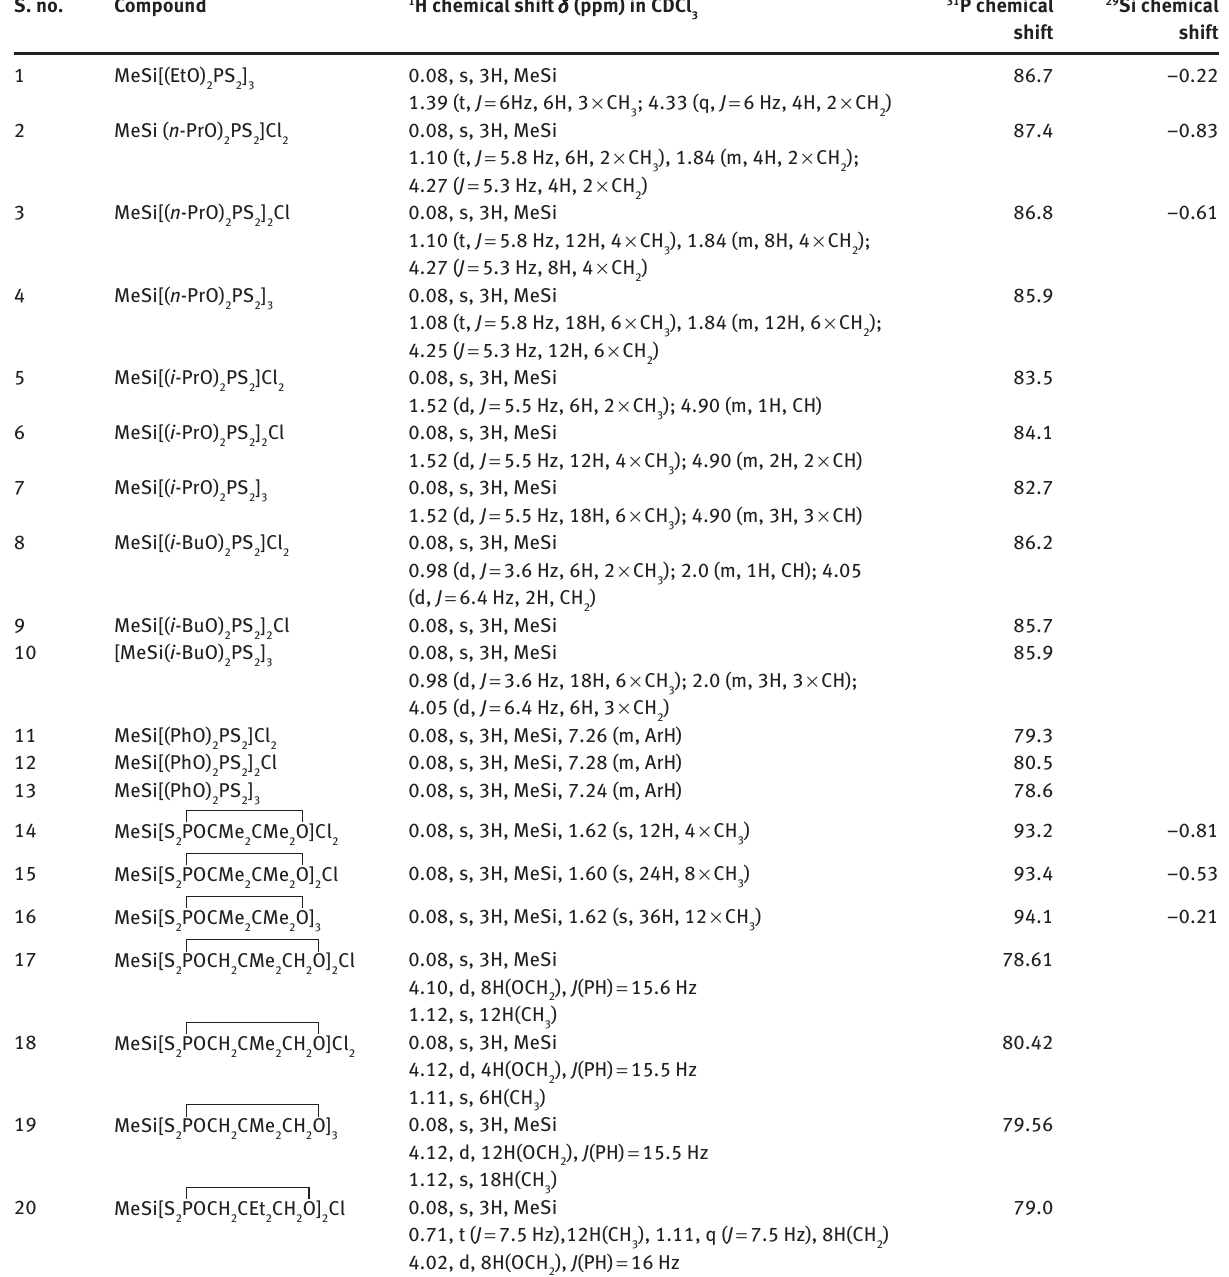
Table 3: 1 H, 31 P, and 29 Si NMR spectroscopic data of methylsilicon (dialkyl and alkylenedithiophosphate) derivatives. S.